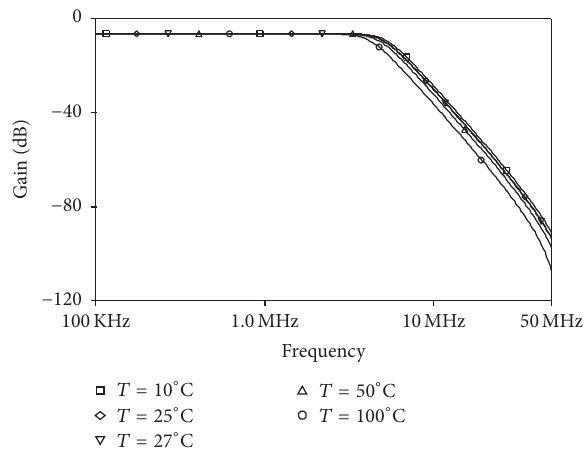
Figure 14: Demonstration of effect of temperature on proposed filter. Table 2: Cut-off frequency at various temperatures. Temperature